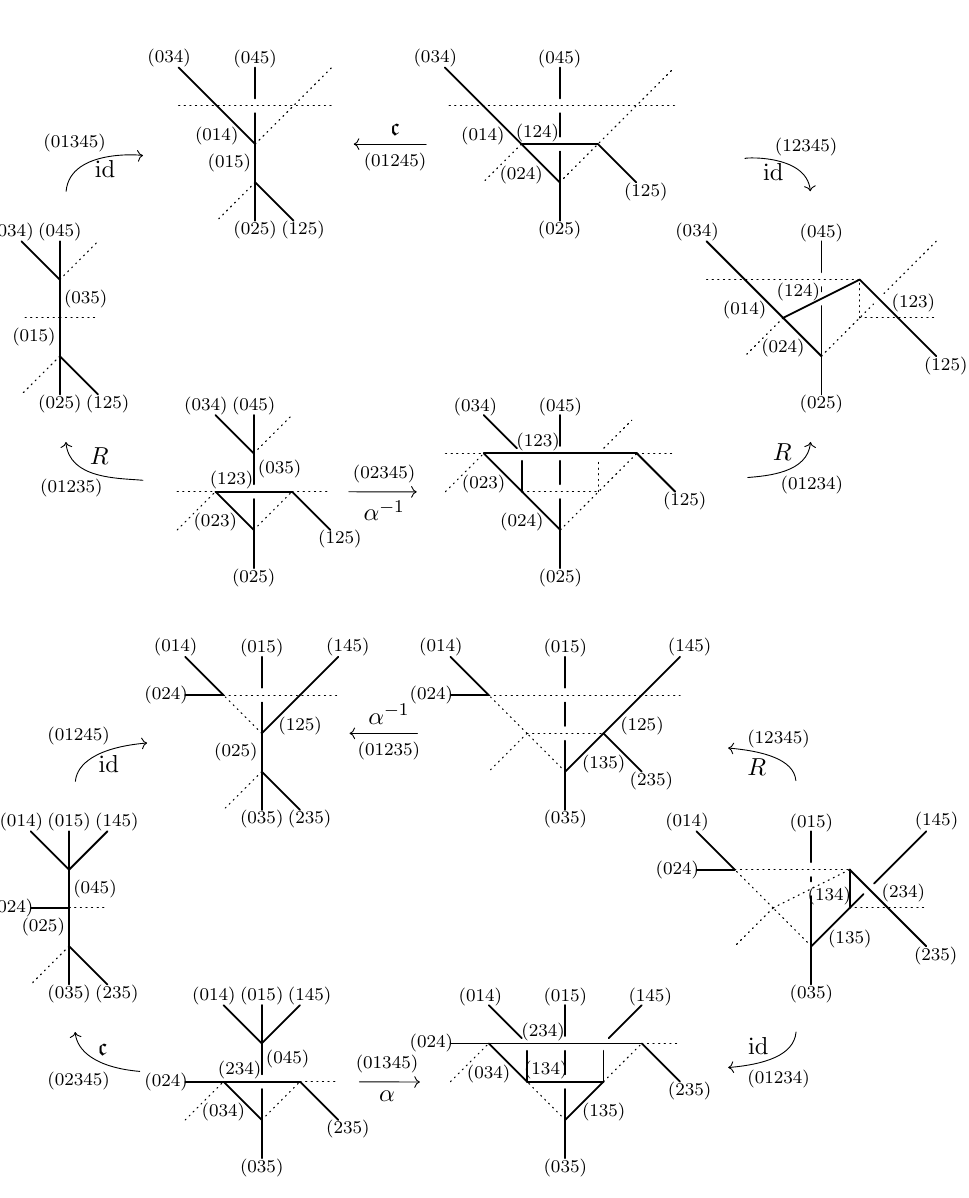
Figure 2 . Graphical depiction of the 2-form cocycle condition d (4) ! (0 ; 0 ; c; d j e; 0 ; 0 j 0 ; 0 j 0) = 1 and d (4) ! (0 ; 0 ; c; 0 j 0 ; 0 ; g j h; 0 j 0) = 1. The dashed line are labeled by the identity group element 0 2 G